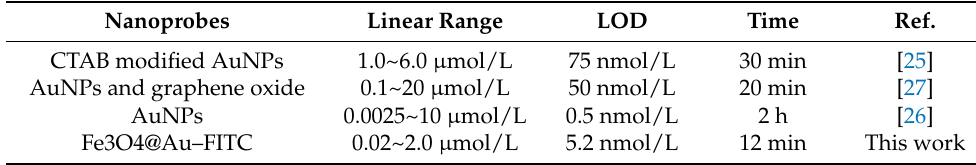
Table 1. Comparison of several methods for Pb 2+ detection.